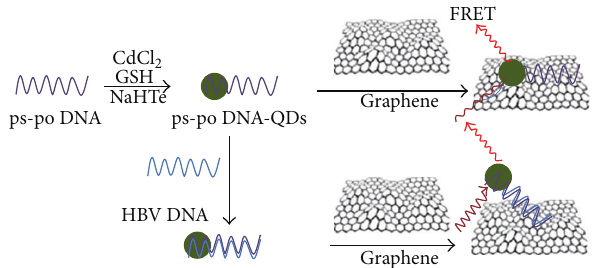
Figure 4: Graphene based biosensing platforms reproduced from Pineda et al. [14] (http://researchgate.net/). Schematic for the prepa- ration of DNA-CdTe quantum dots (QDs) for a FRET assay of